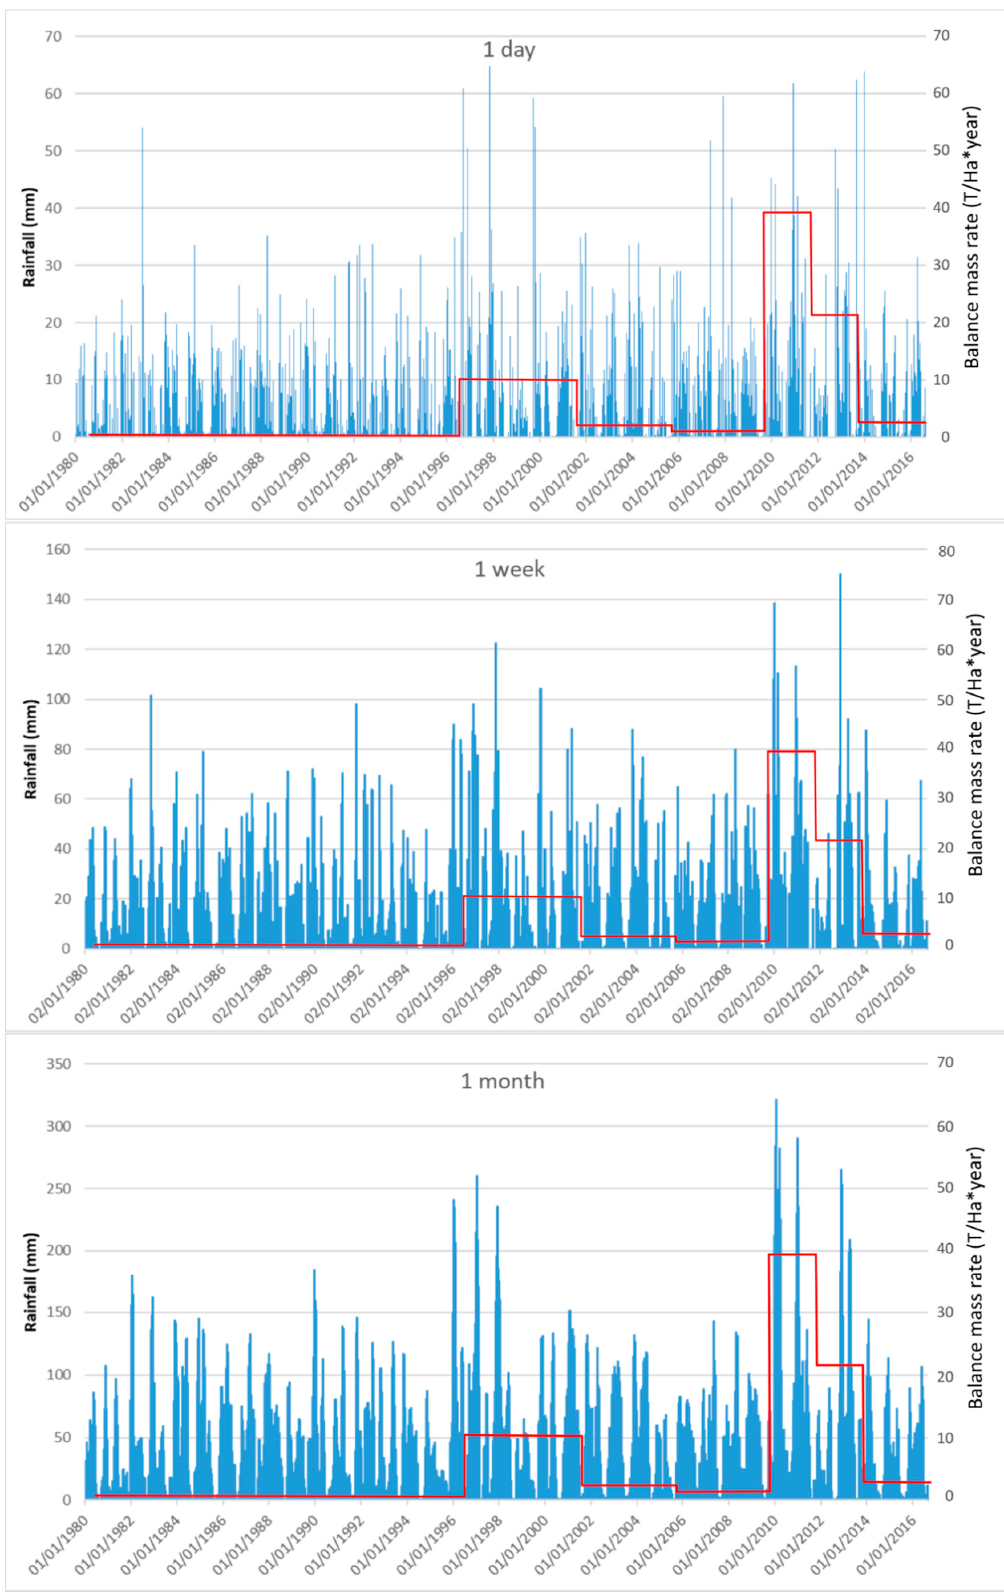
Figure 9. Relationships between erosion processes and rainfall: ( a ) precipitations in 24 hours (1 day); ( b ) precipitations in 7 days (1 week); ( c ) precipitations in 1 month.